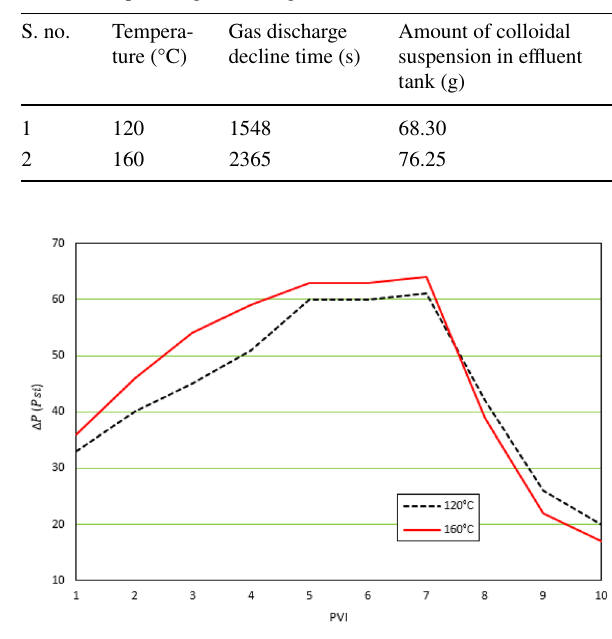
Fig. 6 a Fines concentration variation for increasing pore volume injection (PVI) and b permeability decline for increasing time Fig. 7 Pressure variation for increasing pore volume injection